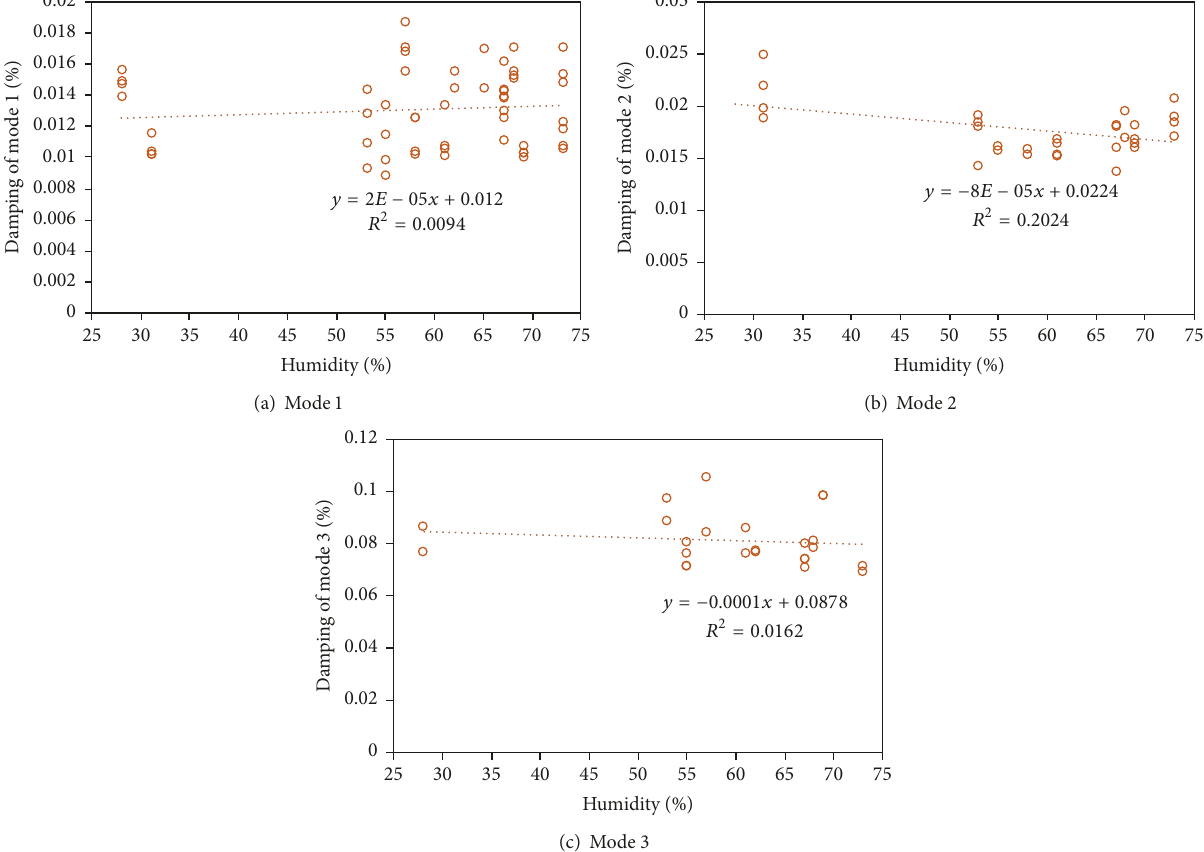
Figure 15: ((a)–(c)) Relation of damping ratios of girder No. 3 to